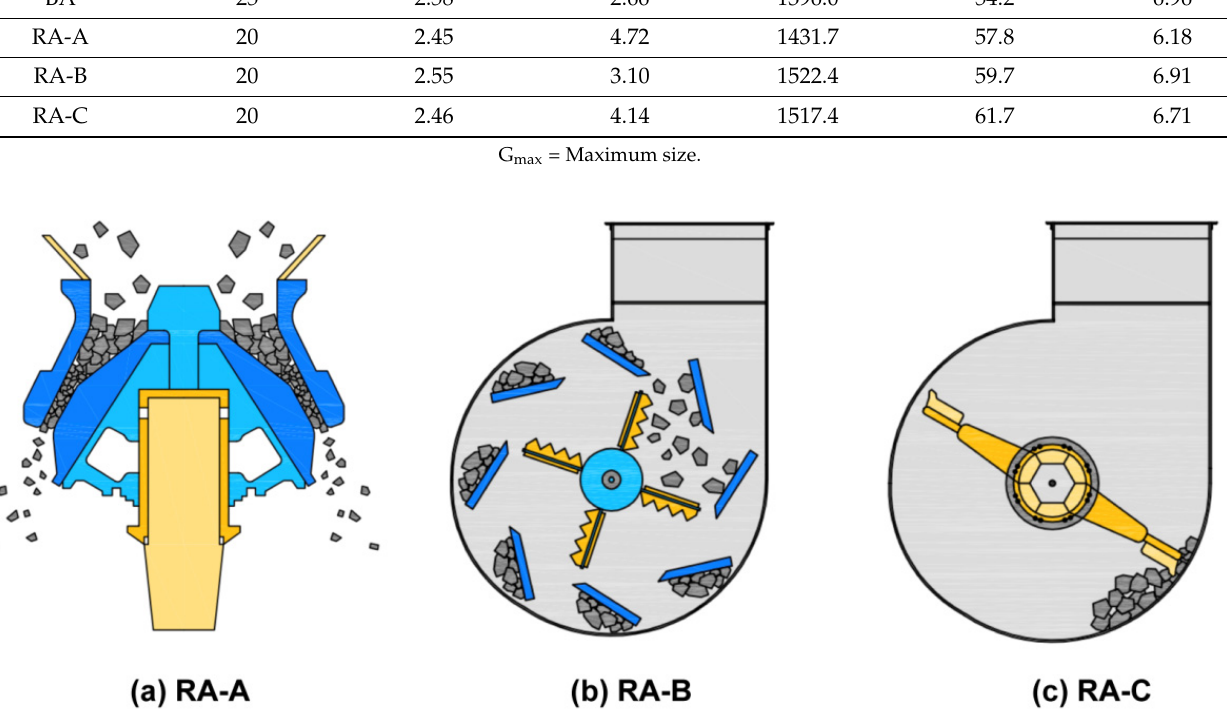
Figure 2. Manufacturing process of the recycled aggregate.